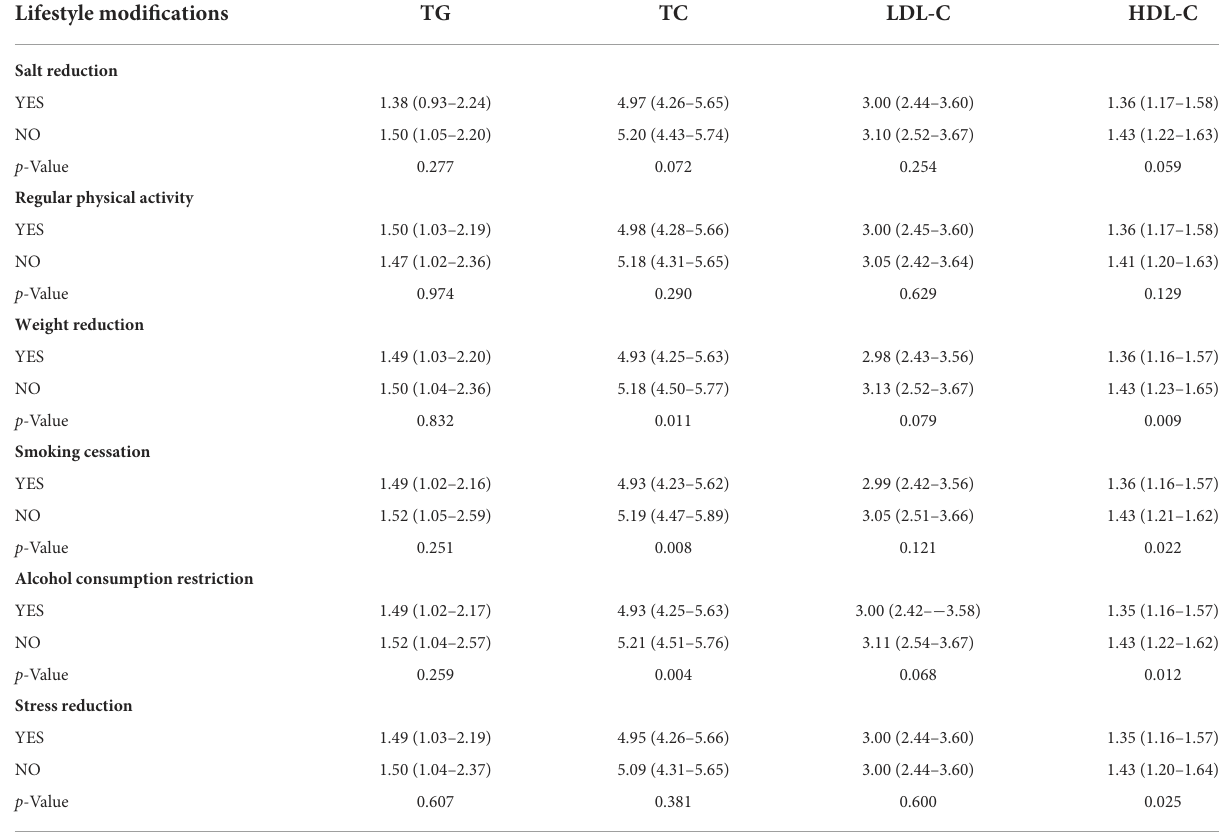
TABLE 3 Differences in blood lipid measurements among patients included in the BPHS group.